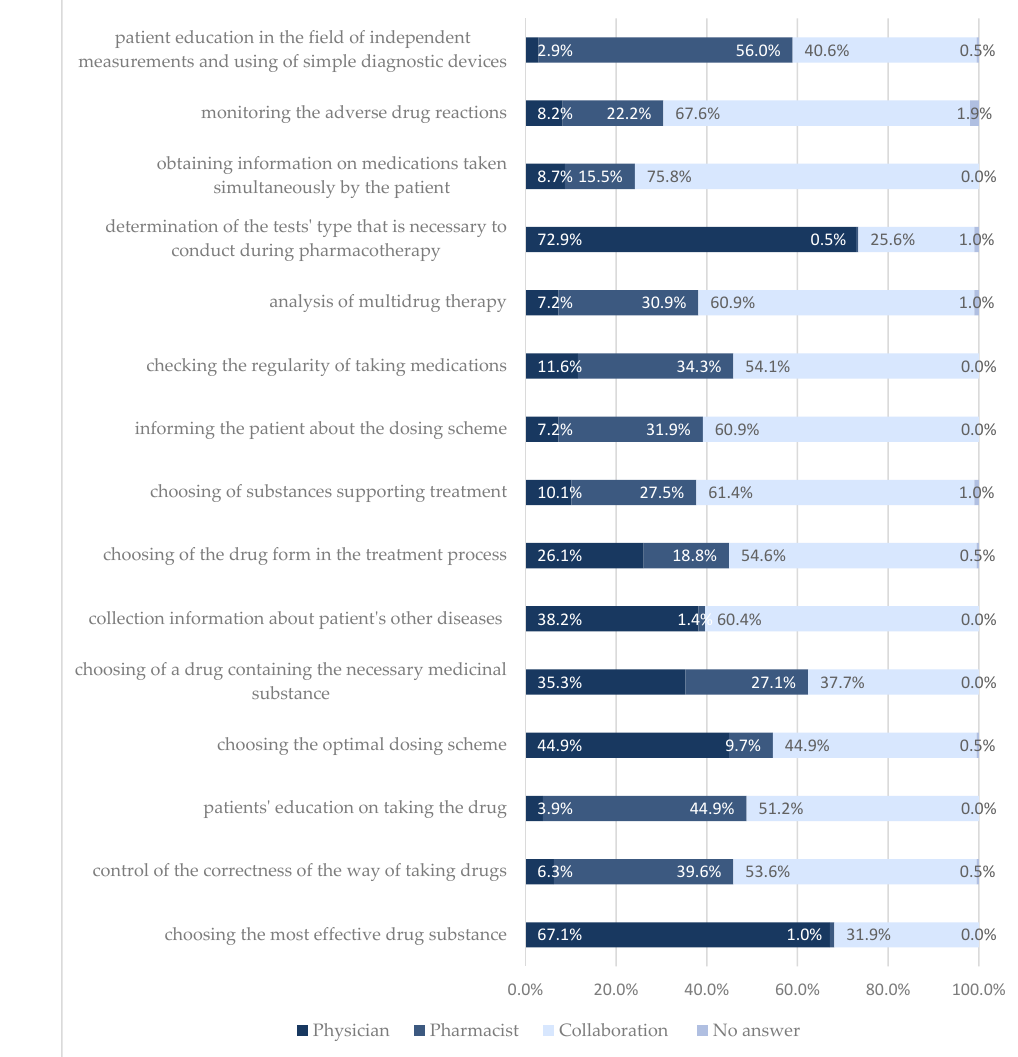
Figure 2. The proposed division of tasks between the physician and the pharmacist.